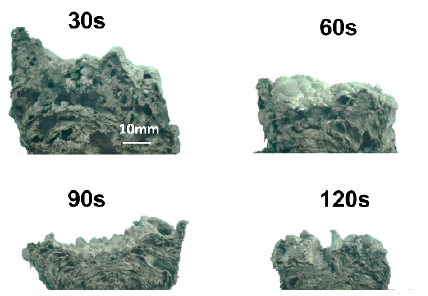
Figure 5. The cross-sectional views of the char at 800 °C with heating time 30, 60, 90 and 120 s.